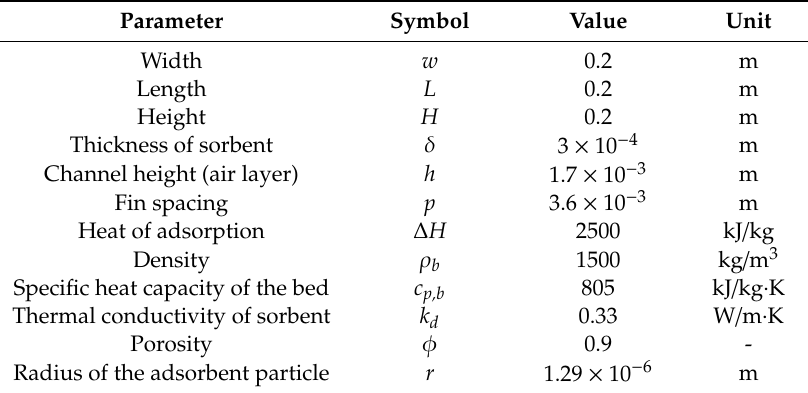
Table 1. Parameters of polymer honeycomb desiccant structure